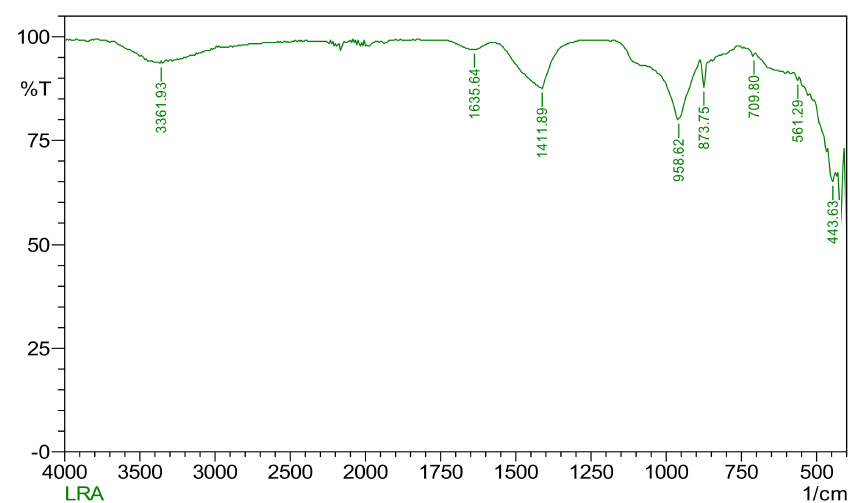
Figure 21. FTIR graph of LSF mortar.